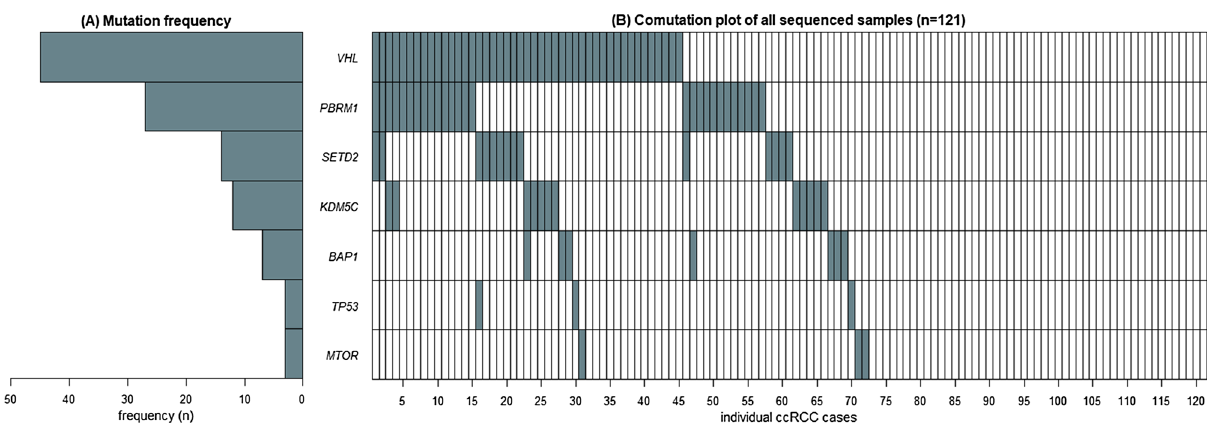
Figure 1. Combinations of mutations present in ccRCC cases in the Netherlands Cohort Study on diet and cancer (N = 121). ( A ) Mutation frequency for the seven selected genes. ( B ) Co-mutation plot of all sequenced samples. Each column represents one ccRCC case. Mutations in the individual genes labelled on the left are shown by the grey-blue